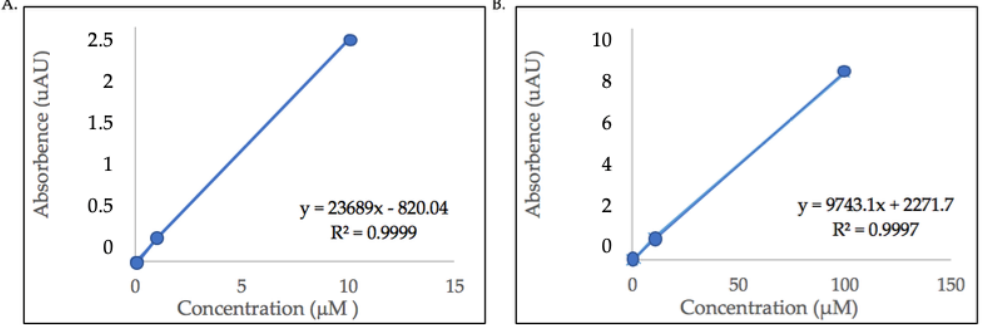
Figure 3. Calibration curves with linear regression lines and equations of ( A ) area under the curve of kaempferol aglycone standard (10, 1, 0.1, 0.01 µ M), and ( B ) area under the curve of quercetin aglycone standard (100, 10, 1, 0.1, 0.01 µ M). All absorbance values ( Y -axis) are multiples of 10 5